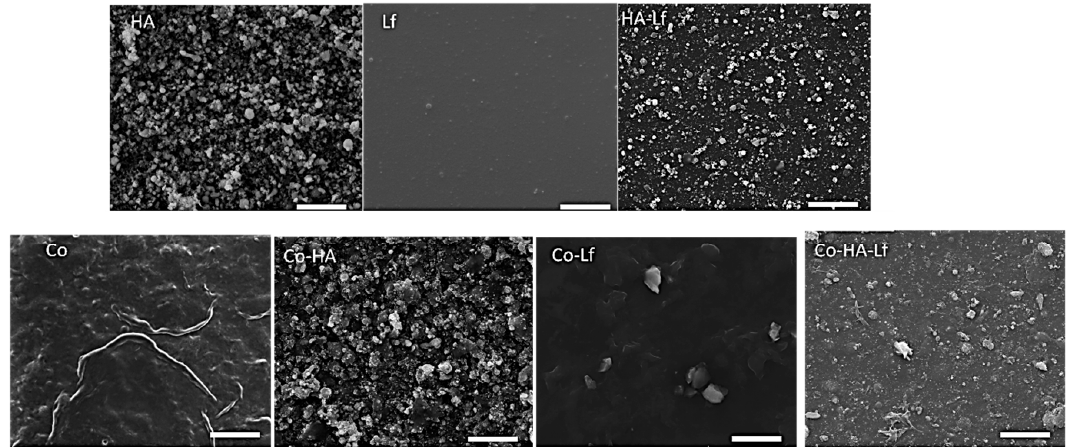
Figure 2. Scanning Electron Microscopy (SEM) images of the top morphology of the coatings obtained by MAPLE. Scale bar: 10 μ m.